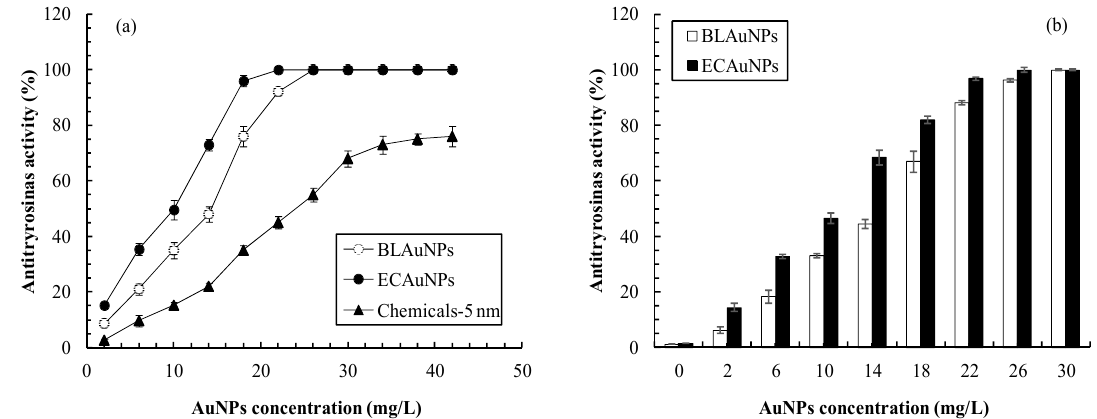
Figure 6. Effects of AuNP concentrations on antityrosinase activities in ( a ) mushroom tyrosinase and ( b ) HEMn cells.